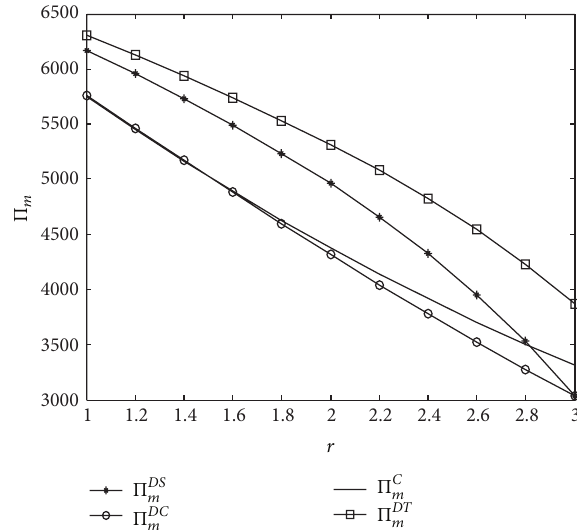
Figure 6: Impact of 𝛾 on manufacturers